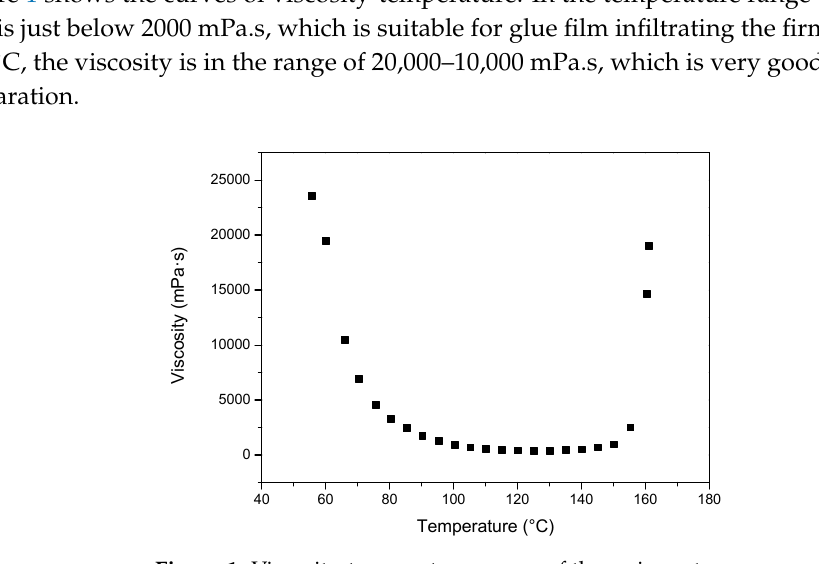
Figure 2. Dynamic mechanical test curves of the rosin-sourced epoxy cast bar.